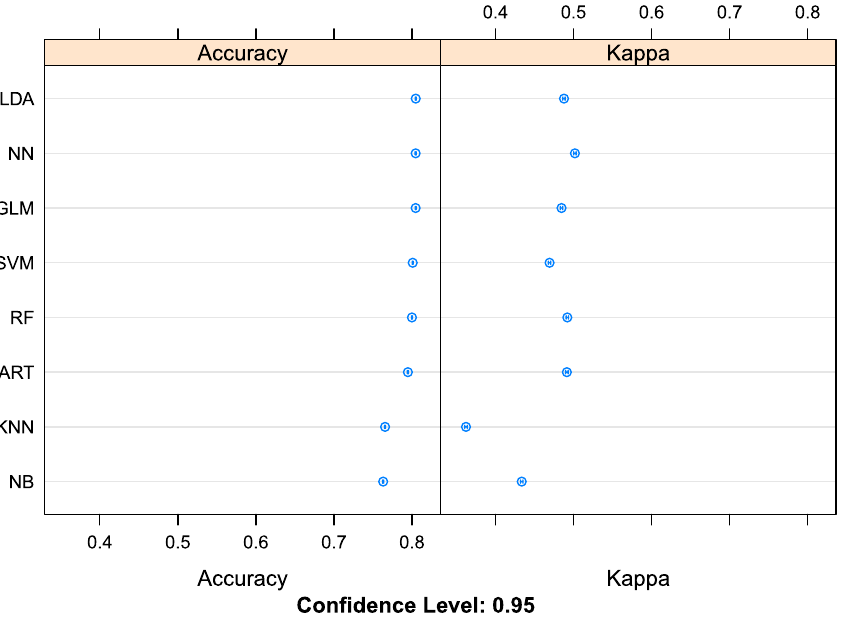
Figure 2. Comparison of the performance (accuracy and kappa value) of eight machine learning methods [Linear Discriminant Analysis (LDA), Neural Network (NN), Generalized Linear Model (GLM) with logit link function, Support Vector Machines (SVM), Random Forest (RF), Classification and Regression Trees (CART), k-Nearest Neighbors (kNN) and Naïve Bayes (NB)], run on the testing set, in prediction of udder health status of dairy cows according to somatic cell count below or above 200,000 cells/mL from cow’s and milk data recorded at the previous test-day